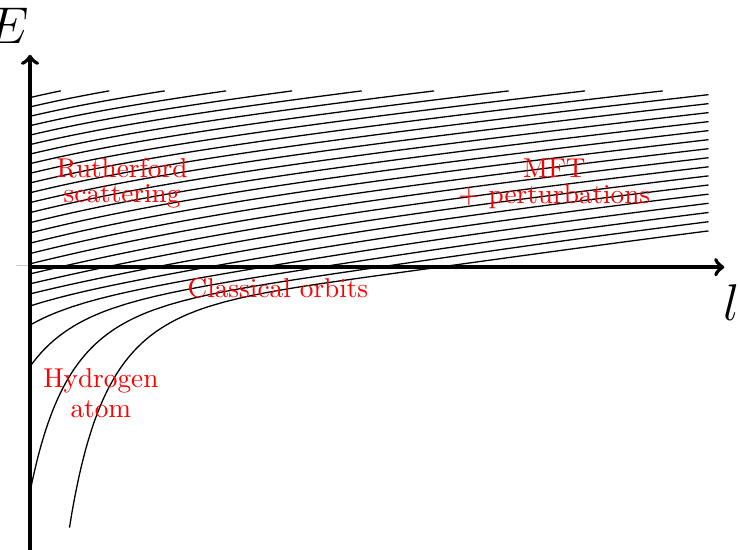
Figure 2 . A sketch of the spectrum (Regge trajectories) of two non-relativistic particles in AdS 4 interacting via a Coulomb potential V ( r ) = − g with µg 2 (cid:29) ω . Energies E l,n depend on spin l r (plotted as a continuous variable, though physical states lie at integer l ) and n = 0 , 1 , 2 , . . . labelling the states in order of increasing energy. Various (overlapping) regions of the diagram encode different interesting regimes. If l is not too large, the spectrum is determined by flat spacetime physics: the phase shifts of Rutherford scattering for E > 0 , and the spectrum of the hydrogen atom for E < 0 . The leading n = 0 Regge trajectory intersects the l = 0 axis at E 0 , 0 ∼ − 1 µg 2 , the 2 binding energy of the hydrogen ground state (not shown on the plot). These hydrogen bound states also describe classical Keplerian orbits for l (cid:29) 1 , circular for small n and increasingly elliptical for larger n . At sufficiently large l or n the spectrum approaches the linear Regge trajectories of MFT, with perturbative corrections controlled by the exchange of the stress tensor and other conserved